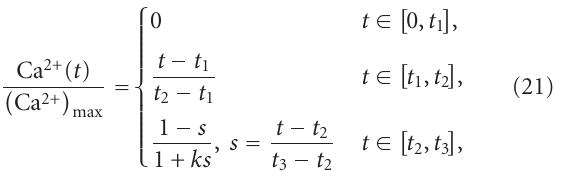
tissues, respectively,